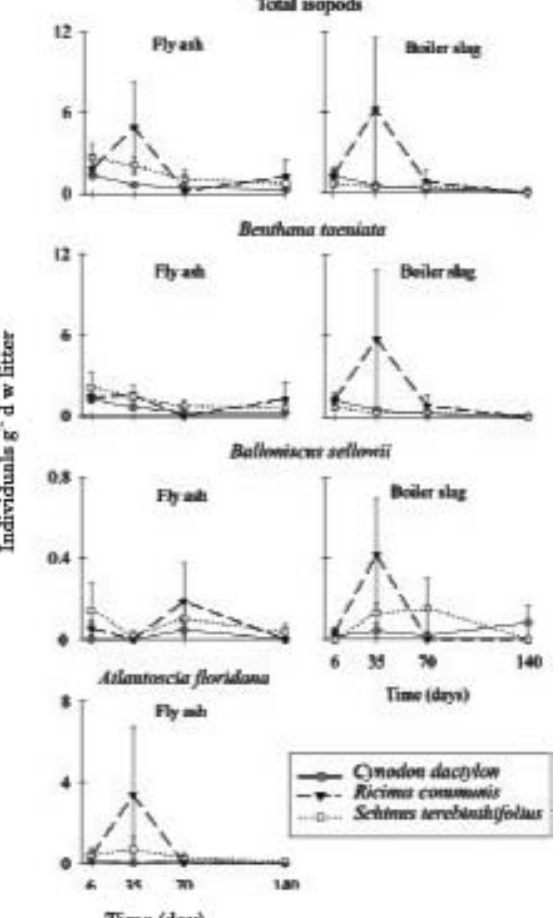
Figure 1. Mean ±±±±± standard error of abundance of terrestrial isopods in different plant species in litter bags in four samplings (after 6, 35, 70, and 140 days) at two coal ash disposal